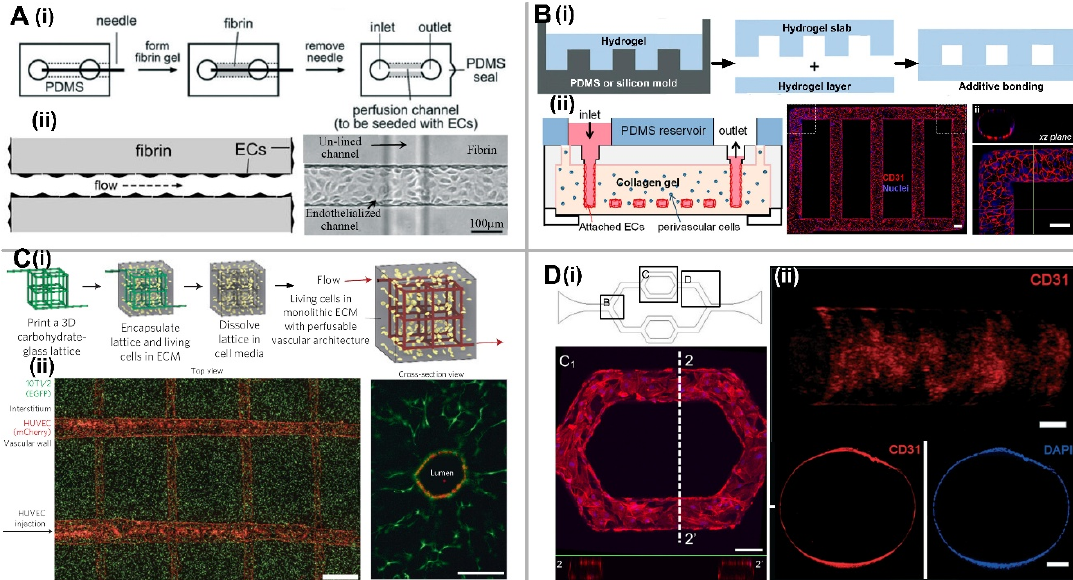
Figure 1. EC lining-based methods for in vitro vascularization. ( A ) Microneedle-based removable method. ( i ) Schematic of the simple needle-molding technique to create fluidic channels inside hydrogels; ( ii ) Endothelialized microchannel under the effect of fluidic flow. Adapted by permission from Reference [13], copyright Wiley Periodicals, Inc. 2012. ( B ) Micropatterned planar hydrogel slab bonding method. ( i ) Schematic of fluidic hydrogels fabricated by micromolding from a PDMS or silicon mold followed by a bonding process; ( ii ) Microvessel network shape inside collagen gel constructed from a micropatterned silicon stamp, and Z-stack projection of horizontal confocal sections of endothelialized microfluidic vessels immunostained with CD 31 from the view of overall network and the corner. Scale bar, 100 µ m. Adapted by permission from Reference [17], copyright National Academy of Sciences, USA 2012. ( C ) Dissolvable materials-based sacrificial micromolding method. ( i ) Schematic of a 3D interconnected microvessel network formed by rapid casting of carbohydrate glass lattice as the sacrificial element with a 3D printer. The lattice is encapsulated in ECM along with living cells and dissolved in minutes in cell media without damage to nearby cells, which can generate a monolithic tissue construct with a vascular architecture. ( ii ) The micrograph (left) shows HUVECs expressing mCherry attached to the hydrogel wall to generate the microvessel network. Scale bar, 1mm. The micrograph (right) shows endothelial monolayer lined vascular lumen surrounded by 10T1/2 cells after 9 days in culture. Scale bar, 200 µ m. Adapted by permission from Reference [18], ( i ) The schematic of PDMS-based microfluidic channel, and the confocal image of endothelial cell